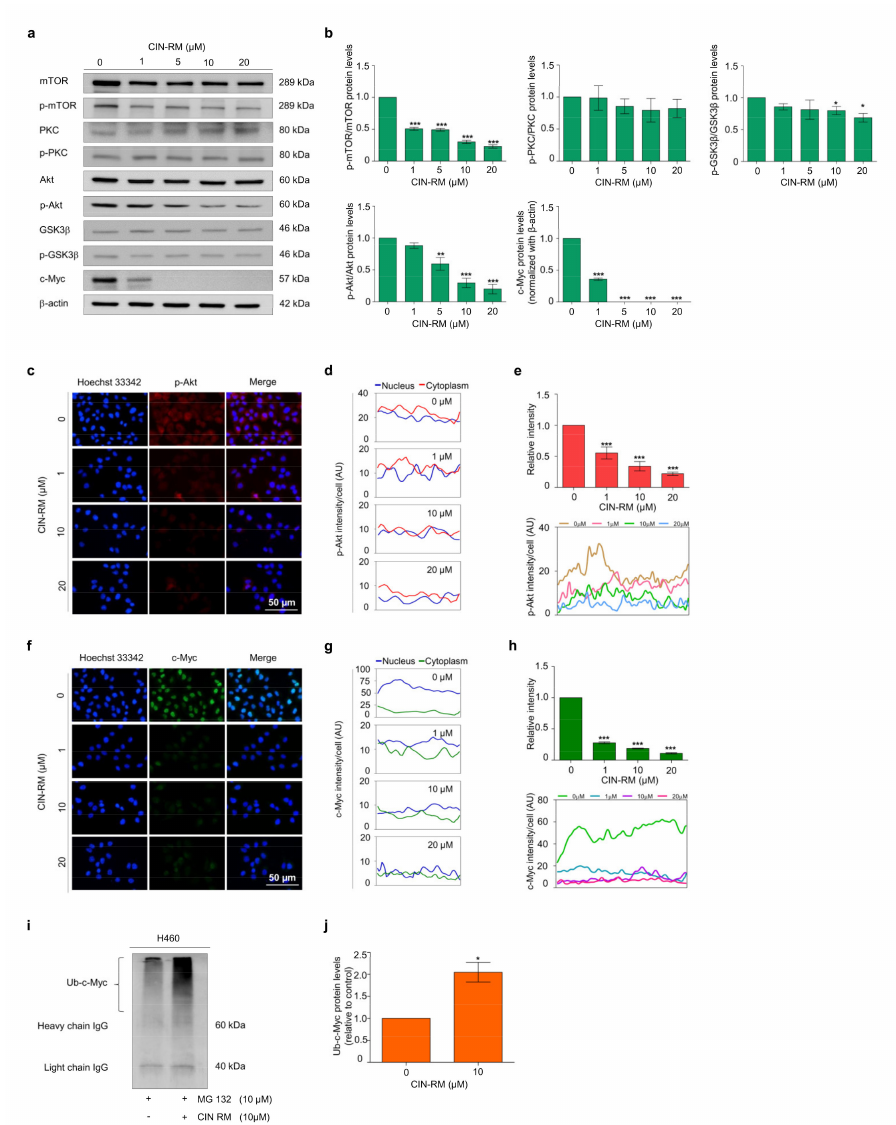
Figure 4. Effect of CIN-RM on Akt/c-Myc signaling pathway. ( a ) H460 cells were treated with various concentrations (0–20 µ M) of CIN-RM for 24 h and the expression levels of mTOR, p-mTOR, PKC, p-PKC, GSK3 β , p-GSK3 β , Akt, p-Akt, and c-Myc protein were investigated by Western blotting. ( b ) Blots were reprobed with β -actin to confirm equal loading of samples. The immunoblot signals were quantified by densitometry. ( c , f ) H460 cells were treated with CIN-RN at toxic concentrations for 12 h. The cellular levels of p-Akt and c-Myc were determined by immunofluorescence analysis. ( d , g ) The fluorescence intensity of the nucleus and cytoplasm were analyzed by ImageJ software. ( e , h ) The fluorescence intensity was analyzed by ImageJ software. ( i ) H460 cells were treated with 10 µ M MG132 for 1 h followed by 10 µ M CIN-RM for 3 h. The specific c-Myc protein was immunoprecipitated using an antibody against c-Myc. The immunocomplex was evaluated by immunoblotting using ubiquitin antibodies. ( j ) Densitometry of Ub-c-Myc protein complex level was calculated. Values are presented as means ± SEM ( n = 3). * p < 0.05, ** p < 0.01, and *** p < 0.001 compared with untreated